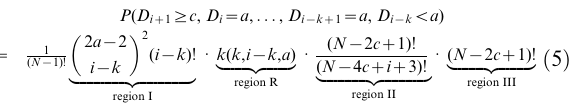
Figure 1. Diagrams explaining Equations 1 and 2 for N ~ 7 , a ~ 1 and c ~ 2 (panel A) and a ~ c ~ 2 (panel B) with the reference point z 1 at coordinates (0,0) . A : We define 3 regions I, II and III (black, red and blue points respectively). Region I has the least number of constraints and the number of admissible configurations is the number of possibilities to draw i points from 2 a positions without replacement nor ordering: The number of admissible configurations for region II is given by the number of rows n r ~ N { 2 c z 1 available and the number of columns which . Region III has the remaining N { 2 c z 1 points freely distributed, yielding ( N { 2 c z 1) ! remain to be filled n c ~ 2 c { i { 2 according to n r ! ( n r { n c ) ! admissible configurations. B : In the case a ~ c we add an additional region R of r points exactly at distance c (green points). There can be r ~ 2, 3 or 4 (cid:4) (cid:5) 2 2 c { 2 i 0 ! admissible configurations with i 0 the number of points strictly inside the square of such points. Region I has size (2( c { 1)) 2 and i 0 distance c . Region IIa and IIb are symmetric and handled analogous to region II in panel A with n r ~ N { 2 c { 1 and n c ~ 2 c { i 0 { r . Region III has ( N z i